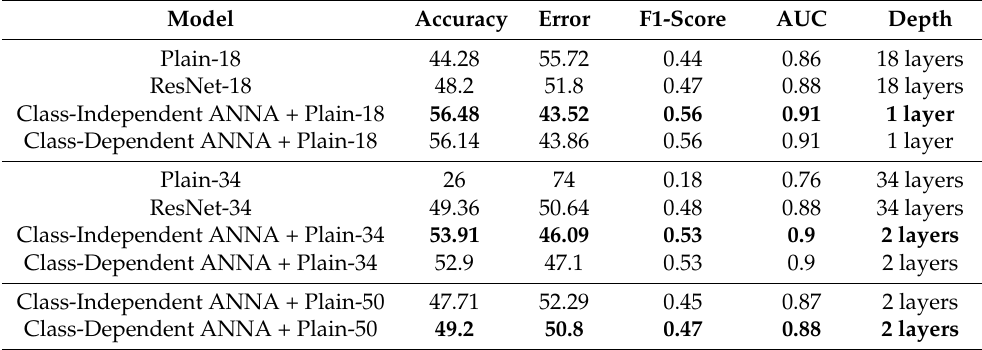
Bold number indicates best